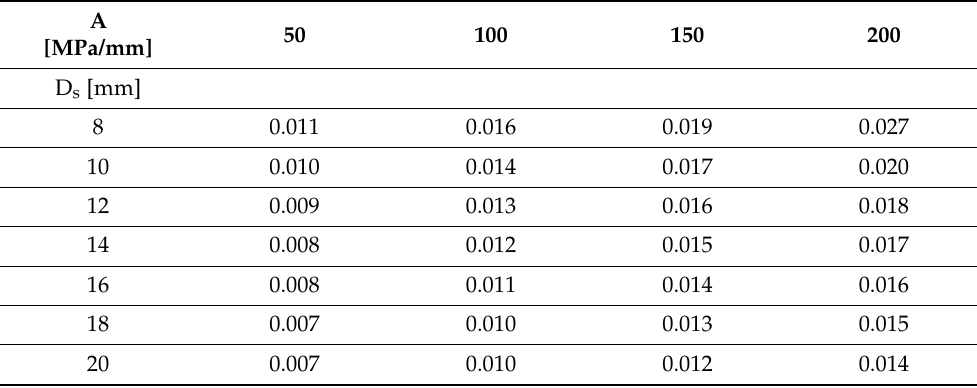
Table 1. Variation of the characteristic length α